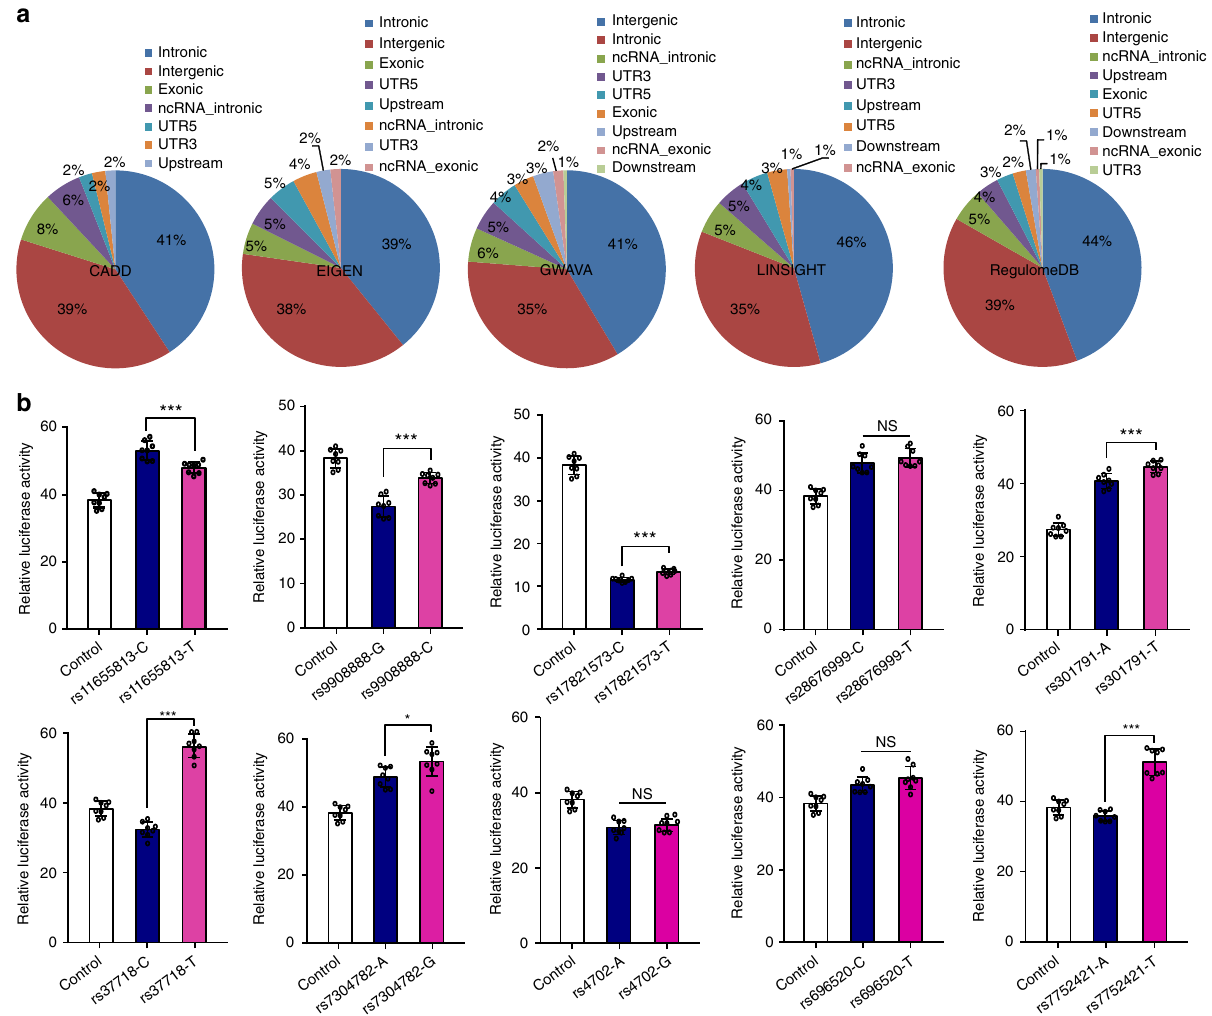
Fig. 2 The distribution of the prioritized top functional single-nucleotide polymorphisms (SNPs) in genome and validation of the regulatory effects of the prioritized top functional SNPs. a Most of the prioritized top functional SNPs were located in intronic and intergenic regions. b Results of the reporter gene assays. Among the 10 tested SNPs, different alleles at 7 SNPs affected the expression of reporter gene signi fi cantly in HEK293 cells ( P < 0.05). Data are expressed as mean ± SD from 8 technical replicates. NS, not signi fi cant, * P < 0.05, *** P < 0.001. Two-tailed Student ’ s t- test. Source data are provided as a Source Data fi